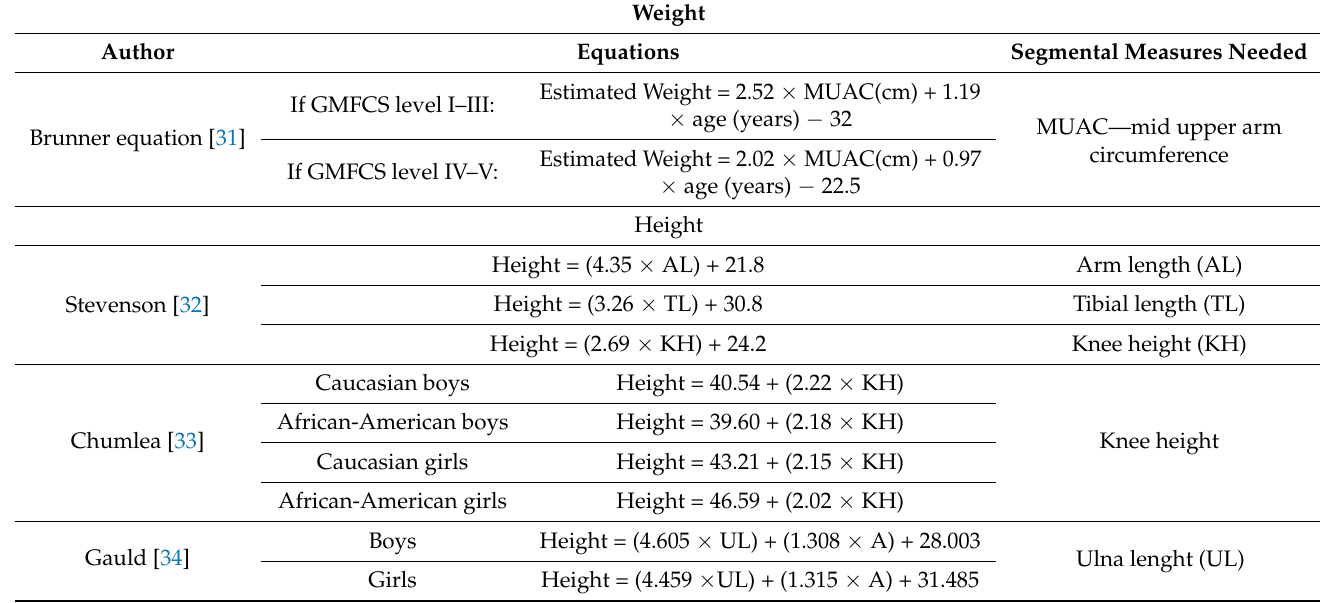
Table 2. Equations to estimate weight and height in children with CP.